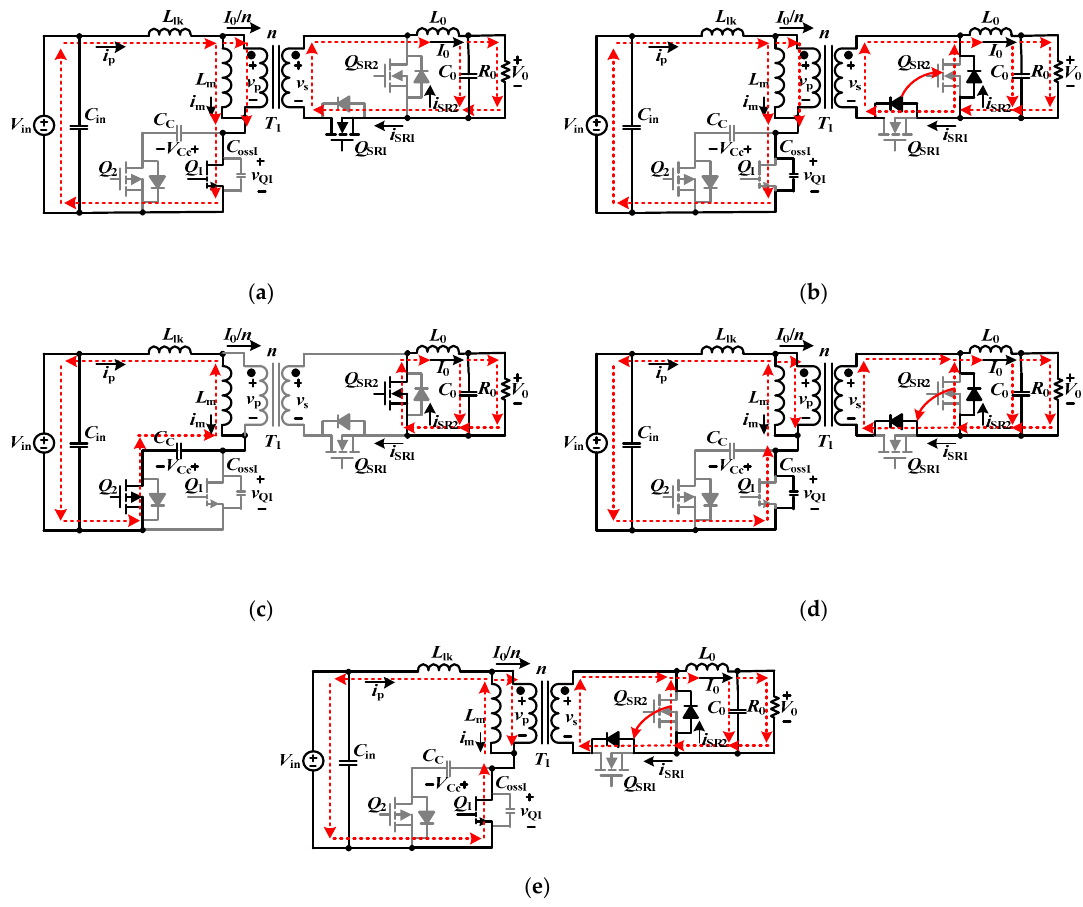
Figure 4. Equivalent circuits for different modes. ( a ) Mode I ( t 0 ≤ t < t 1 ); ( b ) Mode II ( t 1 ≤ t < t 2 ); ( c ) Mode III ( t 2 ≤ t < t 3 ); ( d ) Mode IV ( t 3 ≤ t < t 4 ); ( e ) Mode V ( t 4 ≤ t < t 5 ).